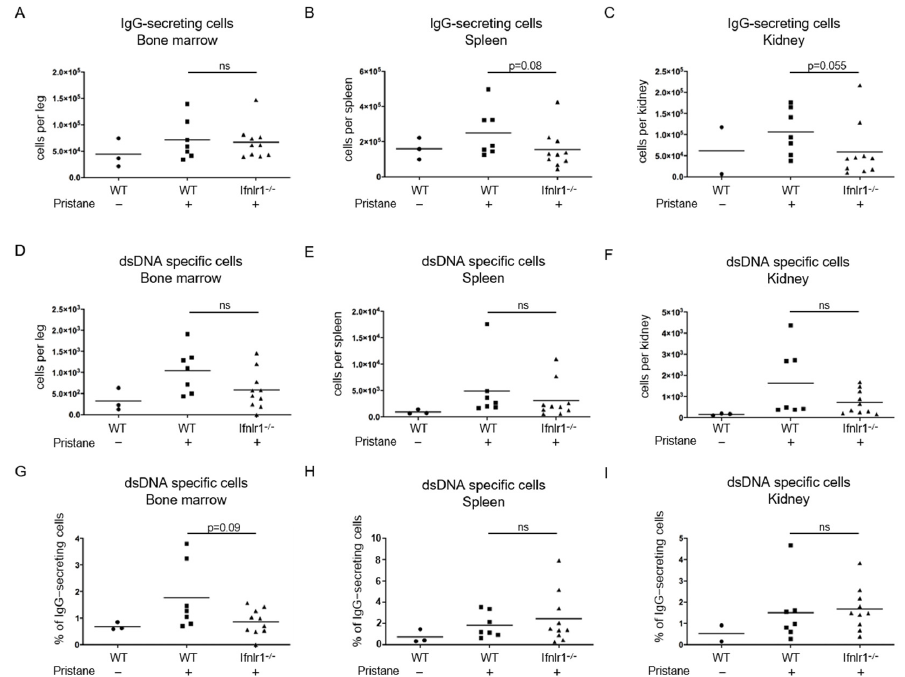
Figure 2. Deficient type III IFN signaling results in a trend towards reduced numbers of antibody- secreting cells in the spleen and kidneys of pristane-treated mice. Numbers of IgG-secreting cells in ( A ) bone marrow, ( B ) spleen and ( C ) kidneys and numbers of anti-dsDNA-IgG-secreting cells in ( D ) bone marrow, ( E ) spleen and ( F ) kidneys at 6 months after pristane treatment were determined by ELISPOT assay. ( G – I ) Percentage of anti-dsDNA-IgG-secreting cells of total IgG-secreting cells in indicated tissues. Each symbol represents an individual sample and all samples were included. Bars represent group mean. Statistical analyses to compare WT + pristane vs. Ifnlr1 − / − + pristane were performed using Mann–Whitney U test; ns = not significant. Values of WT without pristane are shown as reference.